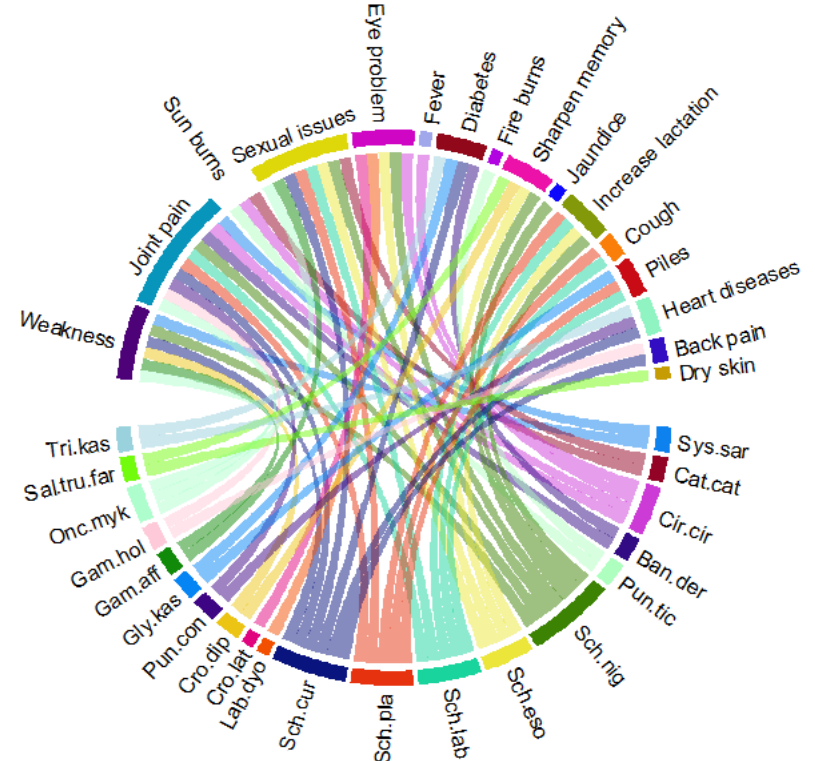
Figure 5. Species distribution for the treatment of specific diseases in the western Himalayan region of Kashmir. Complete names of the species are provided in Table 2.